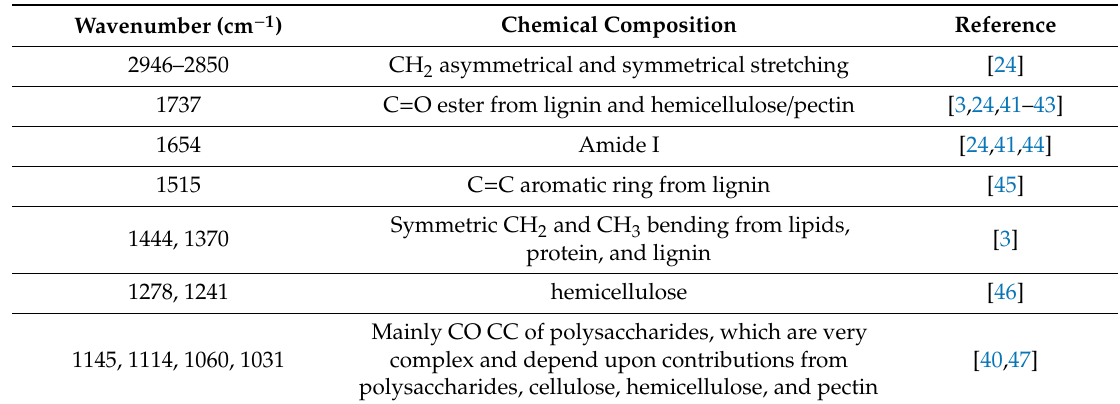
Figure 5. The integral area of average spectra in the ( a ) epidermis and ( b ) mesophyll of rubber tree plants from differently aged plantations. Data followed by the different letters (a, b, and c) are significantly different at p < 0.05. ns: not significantly different. Table 4. Infrared (IR) band assignments of plant